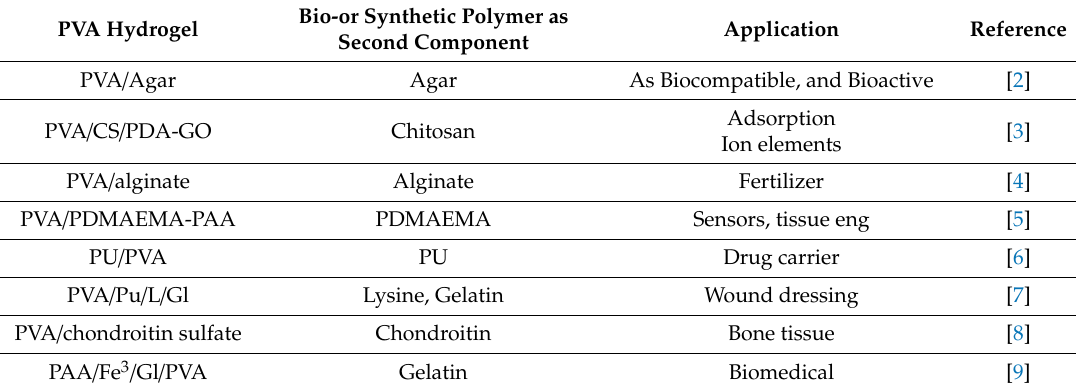
Table 1. Examples of composites and their